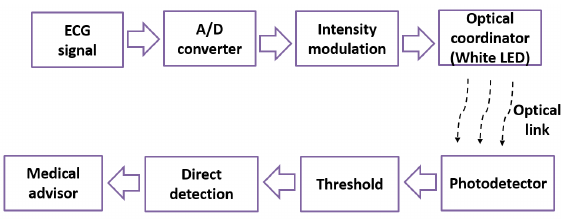
Figure 2. Block diagram of the proposed